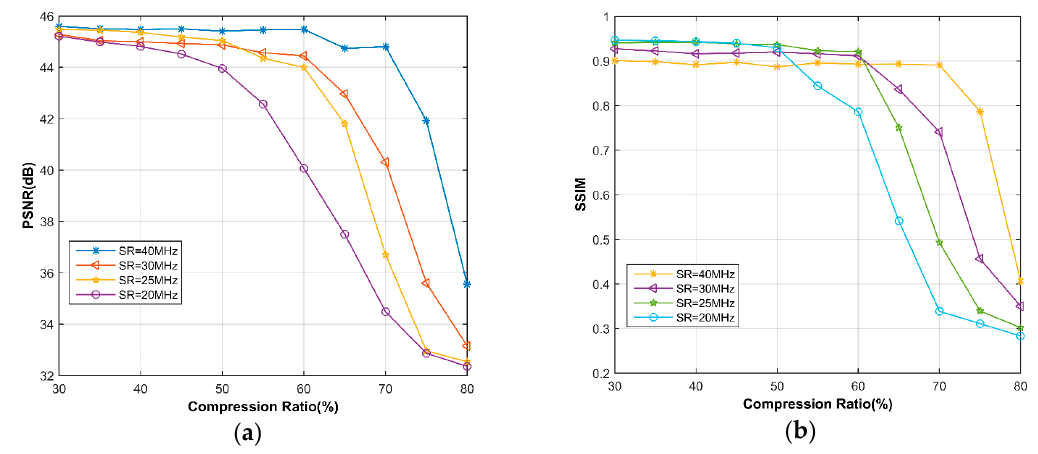
Figure 3. Comparative ( a ) Peak signal to noise ratio (PSNR), ( b ) Structural similarity (SSIM) between different sampling rates (SRs) in the time domain, using simulated data.